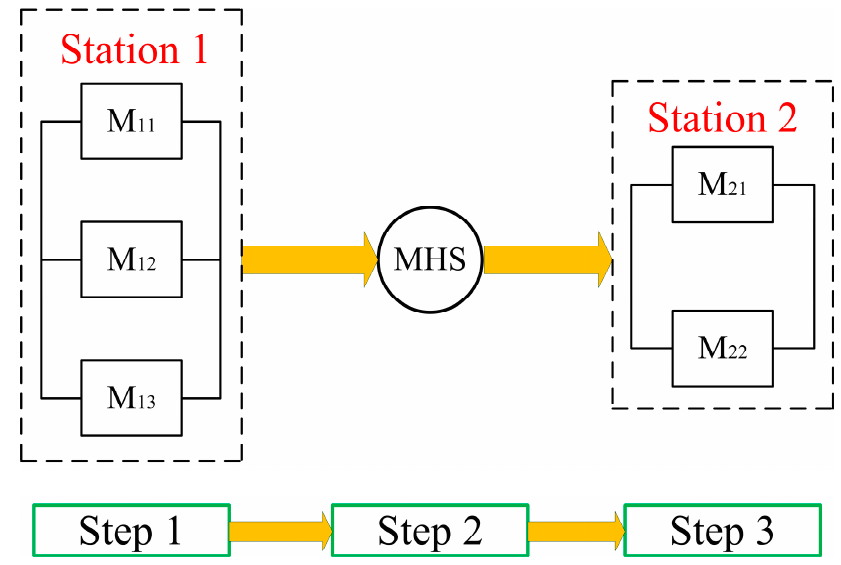
Figure 2. Reliability block diagram of the flexible manufacturing system (FMS) and process to manufacture the product.